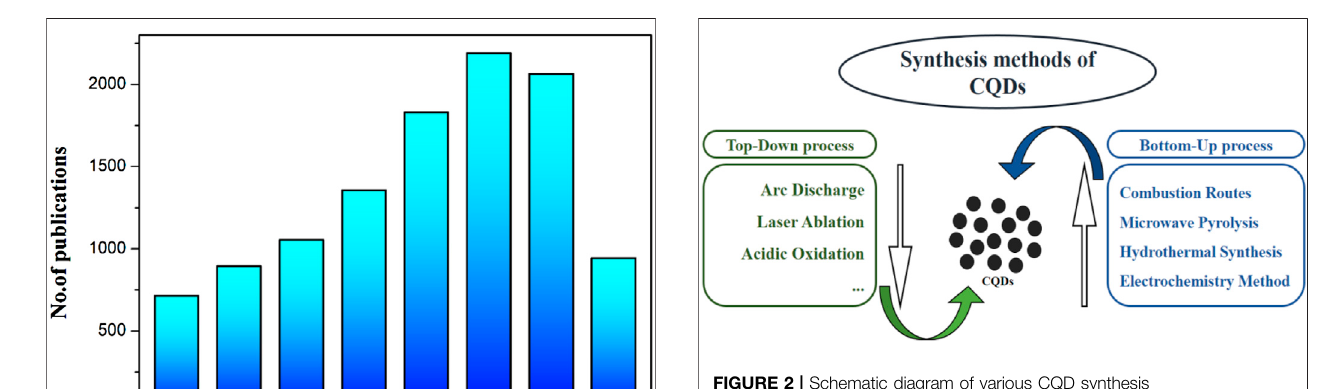
FIGURE 2 | Schematic diagram of various CQD synthesis methodologies.